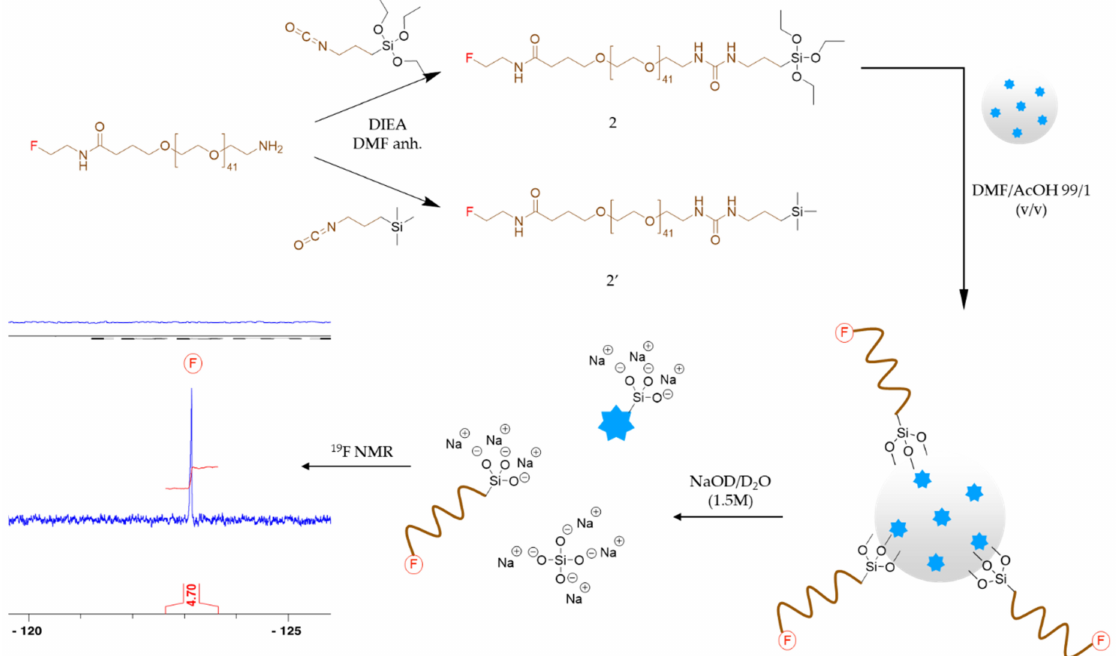
Figure 3. Up: Preparation of hybrid silylated and fluorinated PEG 2 and control molecule 2’ . Down: Preparation of PEGylated type B SiNPs from hybrid compound 2, and the following quantification of fluorine by 19 F NMR after dissolution of a NPs sample in 1.5 M NaOD solution (D 2